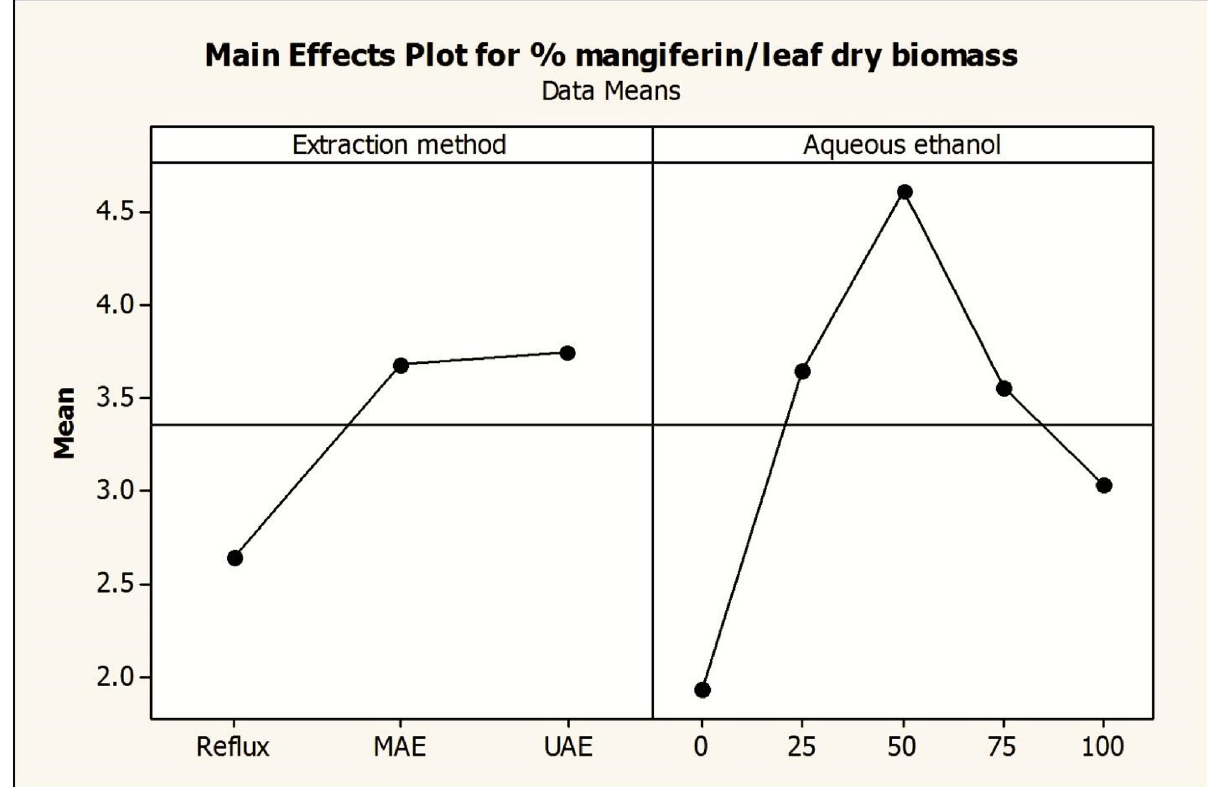
Figure 10. Main plots of extraction methods and aqueous ethanol composition for mangiferin yield from Swertia chirata leaves. Dot is the mean value of mangiferin content.